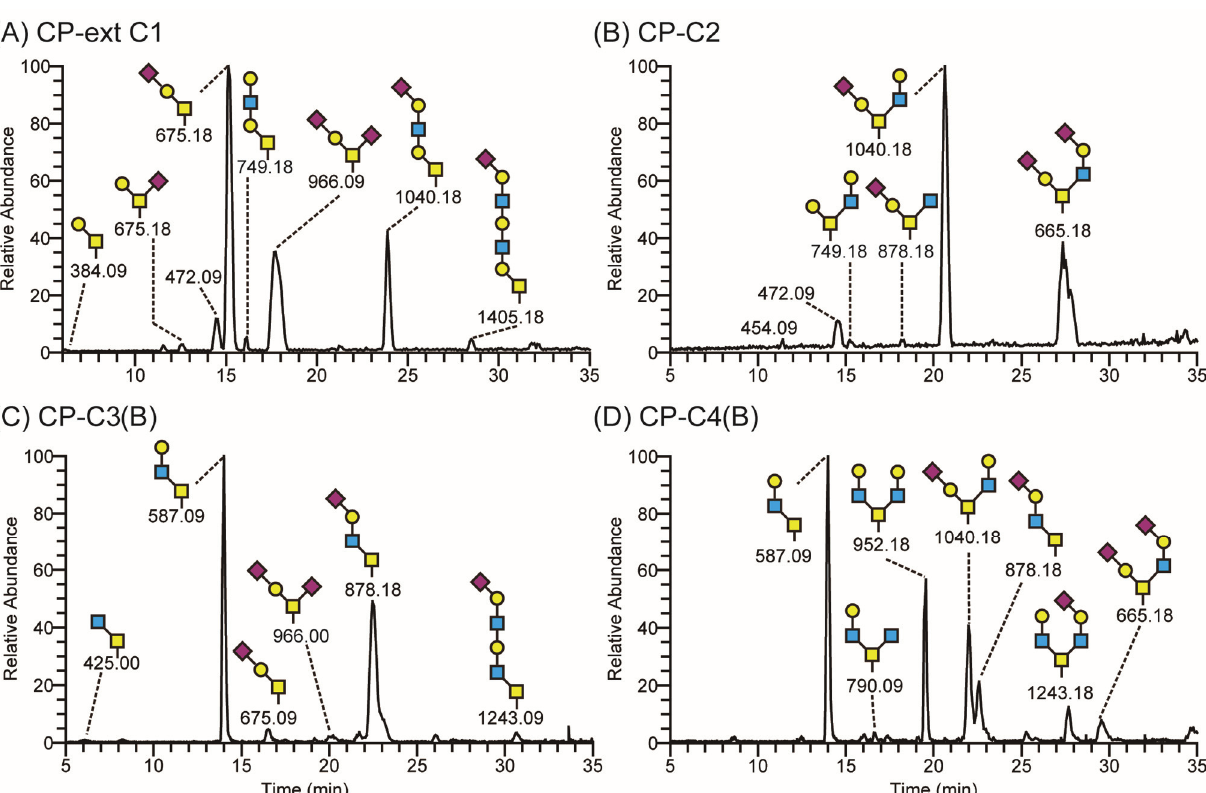
Figure 3. LC-MS chromatograms of O -glycans of recombinant PSGL-1/mIgG2b expressed in CHO-K1 cells stably transfected with O -glycan core glycosyltransferases. CHO-K1 cells stably expressing B3GNT3 and PSGL-1/mIgG2b (CP-ext C1) produced a fusion protein carrying sialylated core 1 and extended core 1 O -glycans ( A ); those expressing GCNT1 (CP-C2) had mostly core 2 O -glycans on the fusion protein ( B ); cells expressing B3GNT6 (CP-C3(B)) secreted PSGL-1/mIgG2b decorated with predominantly core 3 O -glycans ( C ); and cells expressing both GCNT1 and B3GNT6 (CP-C4(B)) carried mostly core 4 O -glycans on PSGL-1/mIgG2b ( D ). Proposed structures are depicted using the Consortium for Functional Glycomics symbol